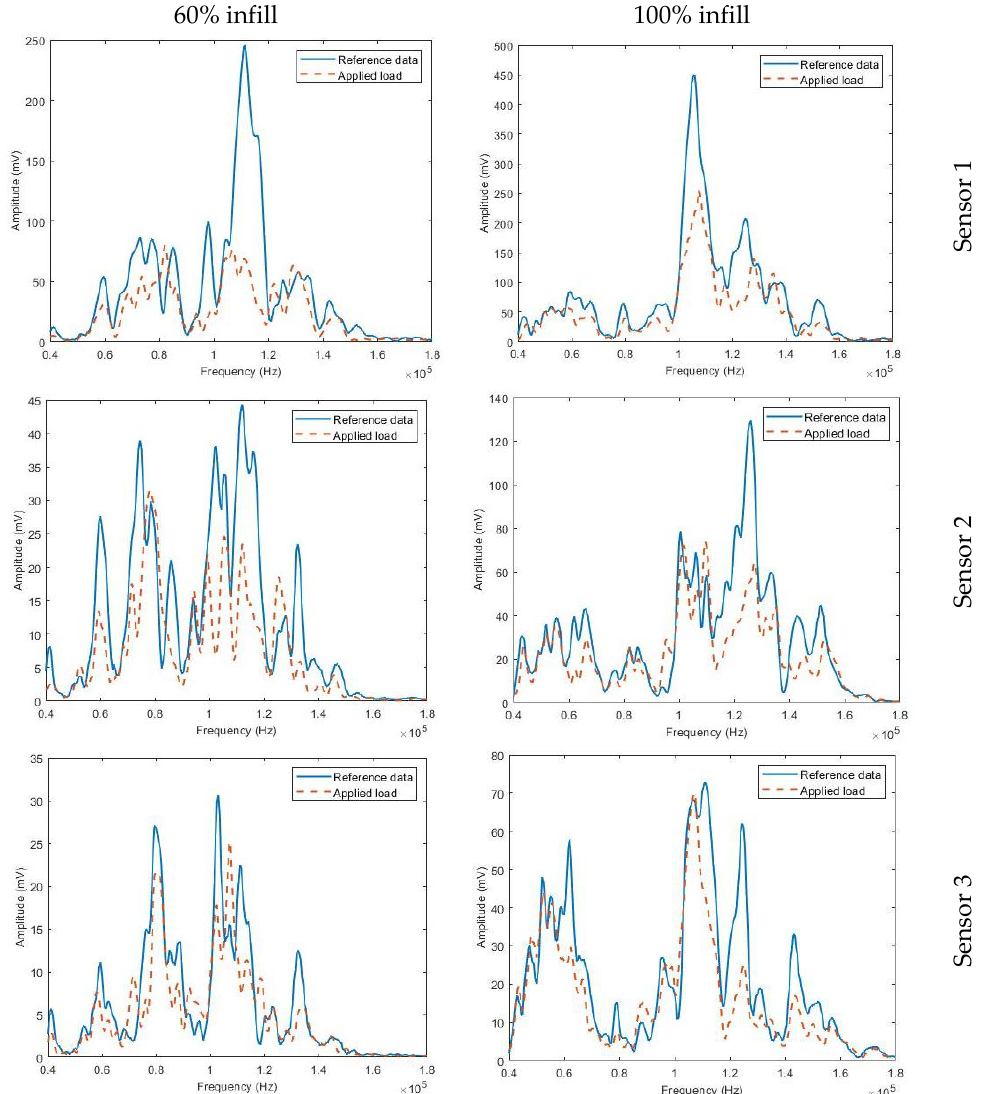
Figure 7. Spectrums of the sensors for baseline and loaded cases when the beams had higher infill density.